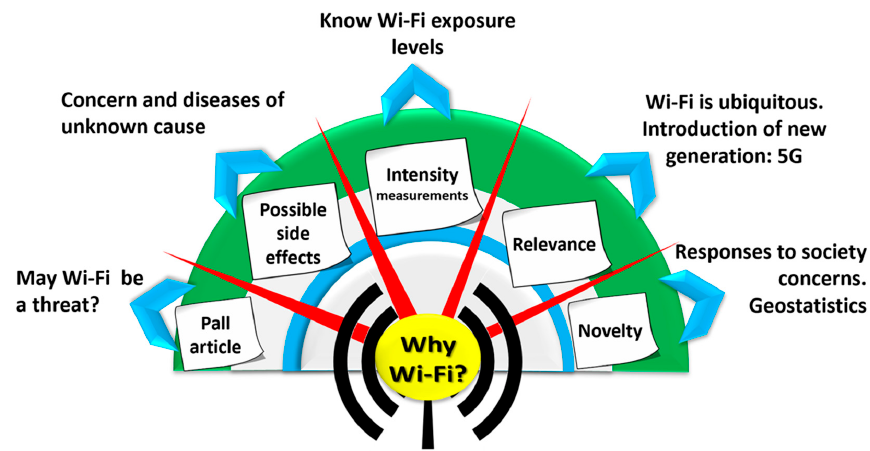
Figure 1. Reasons that motivated us to measure levels of exposure to highlighting wireless fidelity (Wi-Fi) electromagnetic radiofrequency (RF-EMF).